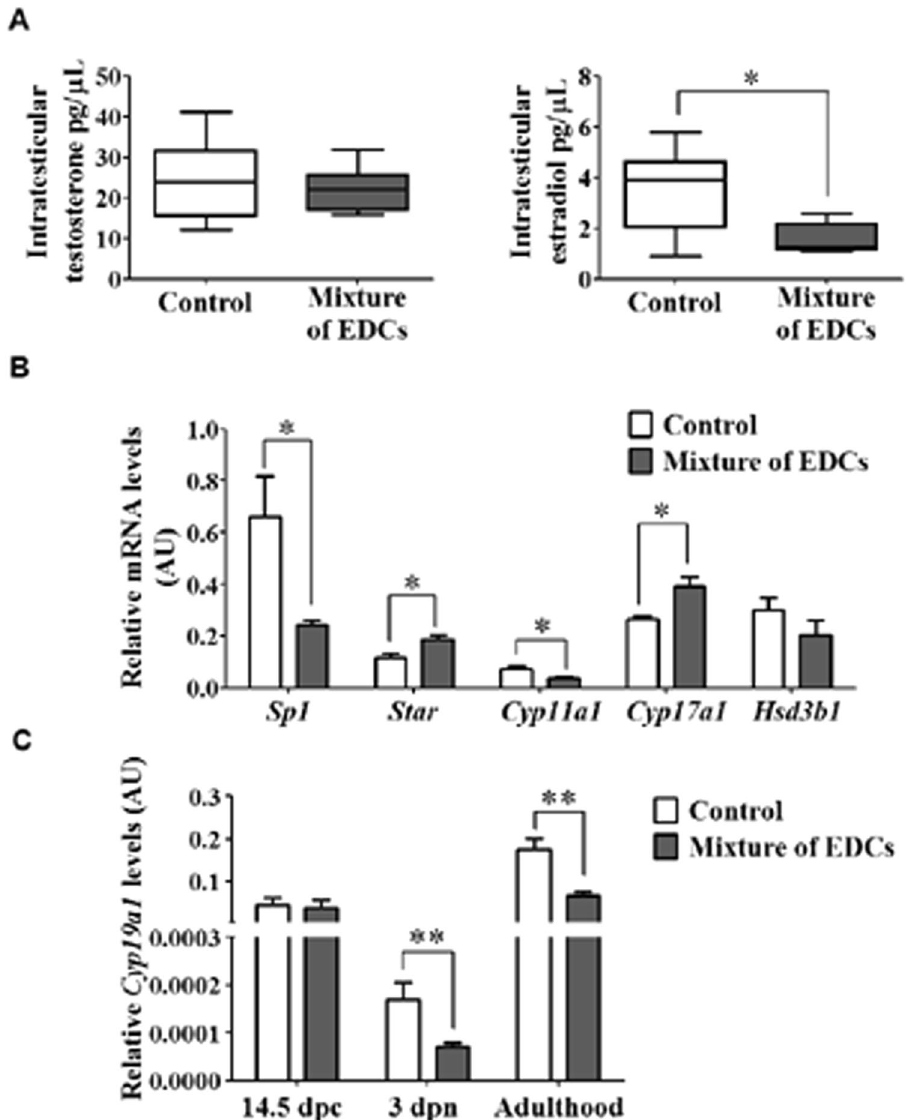
Figure 3. Steroidogenic-pathway enzyme deregulation and estradiol decrease in mice exposed to the mixture of EDCs. ( A ) Testosterone and estradiol levels of seminiferous tubular fluid were measured by RIA, two individual measures per testis (right and left) run in duplicate. ( B ) RT-qPCR of genes implicated in the steroidogenic process. ( C ) Cyp19a1 expression levels in embryonic gonads of male mice on post-coital day (dpc) 14.5, postnatal day (dpn) 3, and adult mouse testes at postnatal day 60. All graphics represent the mean ± SEM, n = 4. Unpaired t test, * p < 0.05, ** p < 0.01. Abbreviation: AU, arbitrary